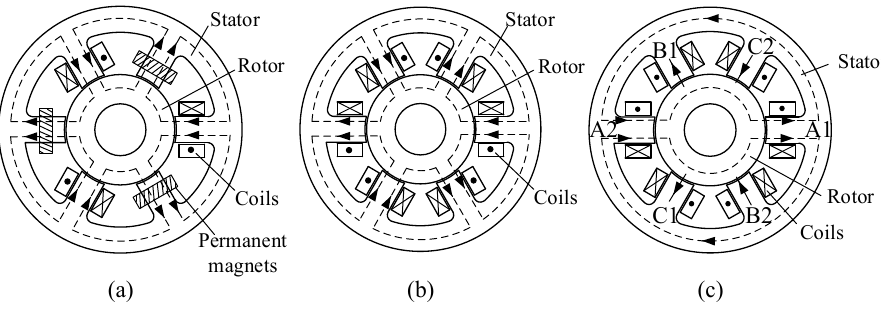
Figure 5. The 6 ‐ pole RMB structure. ( a ) Hybrid permanent magnet structure. ( b ) Six ‐ power ampli ‐ fier drive models. ( c ) Three ‐ phase six ‐ pole drive models. drive models. ( c ) Three-phase six-pole drive